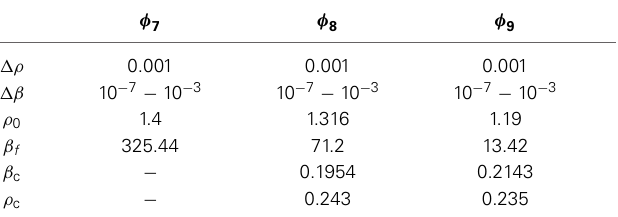
Table 4 | Parameters used in numerical computations for Models 7–9.